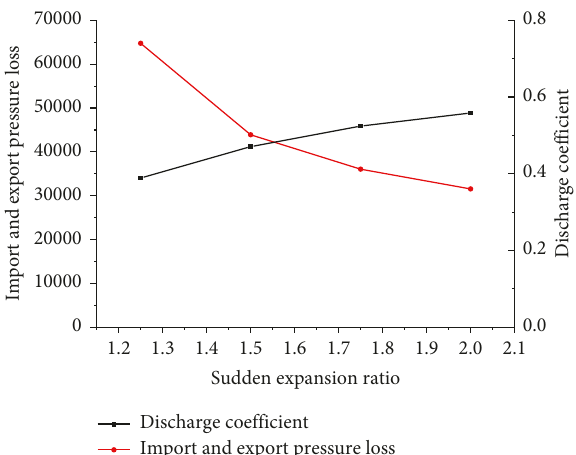
Figure 18: Flow coefficient of different sudden extension ratios and the pressure difference between import and export.